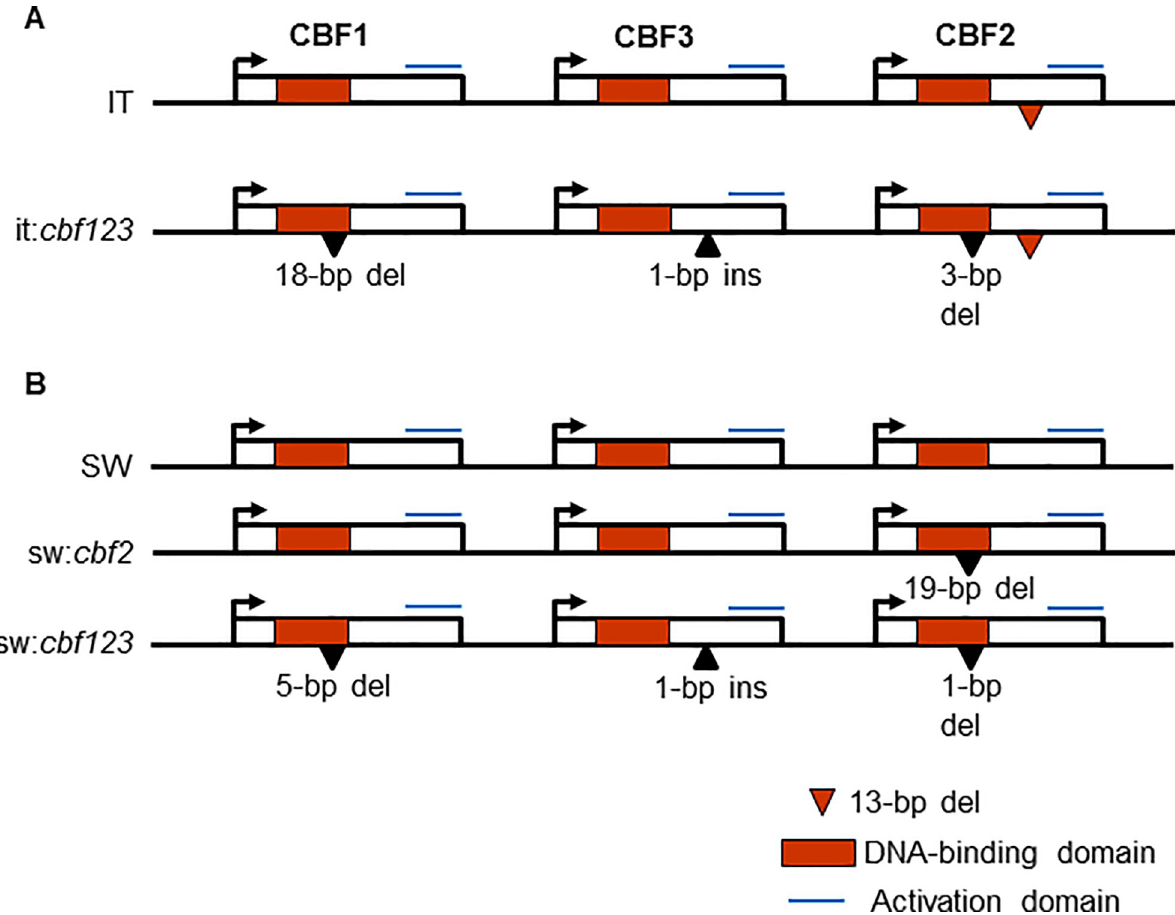
Fig 1. CRISPR-induced mutations in the IT and SW CBF genes. Boxes indicate CBF1 , CBF2 , and CBF3 coding regions (red portion indicates DNA binding domain) in the order they are arranged in the genome (not to scale). Black triangles indicate insertion (ins) or deletion (del) mutations. Red triangles indicate site of the natural mutation in the IT CBF2 gene. The blue lines indicate the activation domain. The mutations within the IT (A) and SW (B) CBF1 , CBF2 and CBF3 coding regions are shown in S1A–S1C